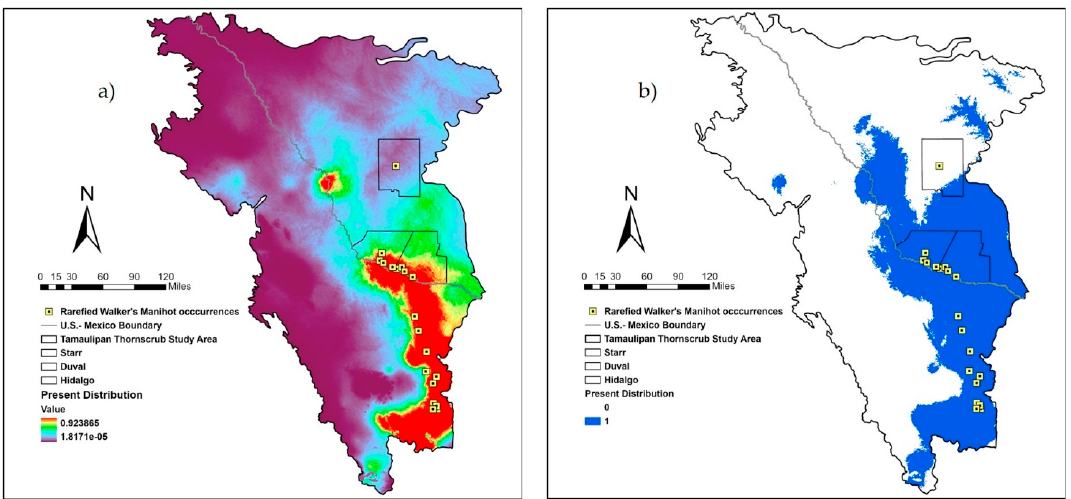
Figure 2. Consensus models of present geographic distribution for Manihot walkerae based on ten bioclimatic variables and 19 spatially rarefied occurrences. ( a ) The color scale ranges from blue to red, with blue depicting areas of unsuitable distribution (value: 0) and red areas with highest potential of distribution (value: 1). ( b ) Binary model, blue areas are potentially suitable. The calculated area under the curve (AUC) and partial receiver operating characteristics (pROC) values for this model are 0.925 and 1.874, indicating good performance.